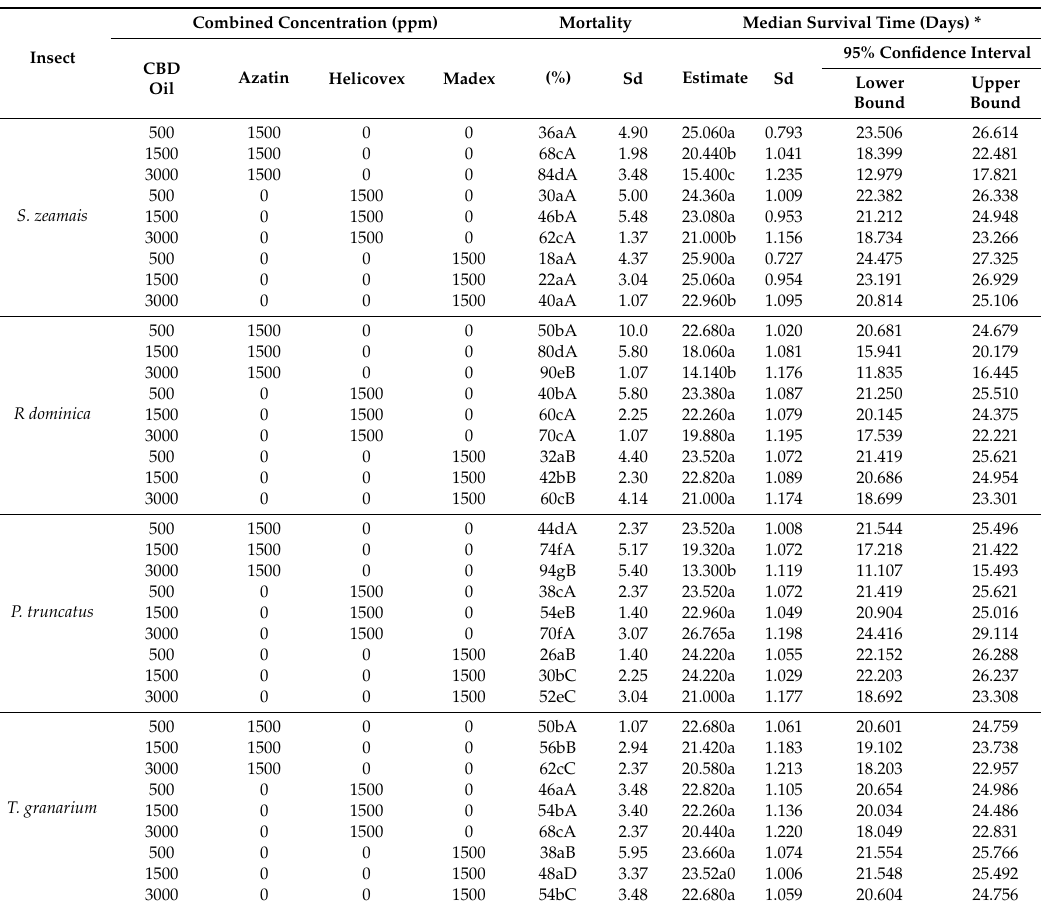
Table 2. Mean% mortality and median survival time (days) adults of S. zeamais , R. dominica , P. truncatus and T. granarium treated with CBD oil in combination with Azatin, Helicovex and Madex. Mean% mortality for di ff erent concentrations or biopesticide, within the same insect and pathogen, followed by the same small letter are not significantly di ff erent; mean% mortality for di ff erent insect, within the same concentrations or biopesticide, followed by the same capital letter are not significantly di ff erent (Bonferroni test, a = 0.05). Estimate median survival time (days) of the same insect followed by the same small letter are not significantly di ff erent (Kaplan–Meier, a = 0.05). * Median survival time ( S. zeamais